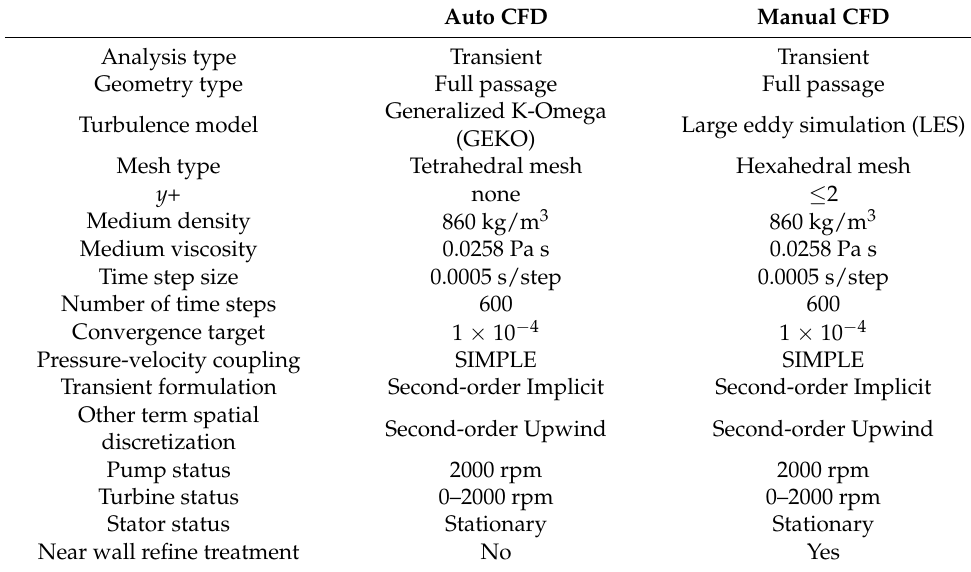
Table 2. CFD model parameters.